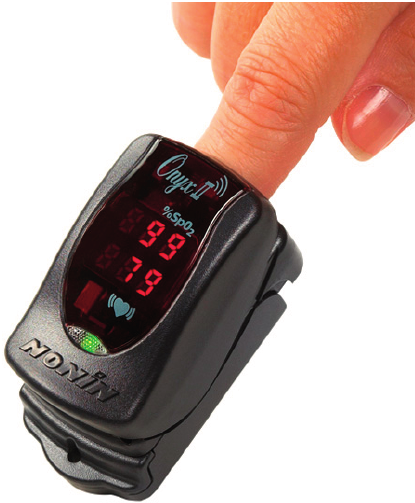
Figure 8. The Onyx ® II Model 9560 Finger Pulse Oximeter developed by Nonin Medical,